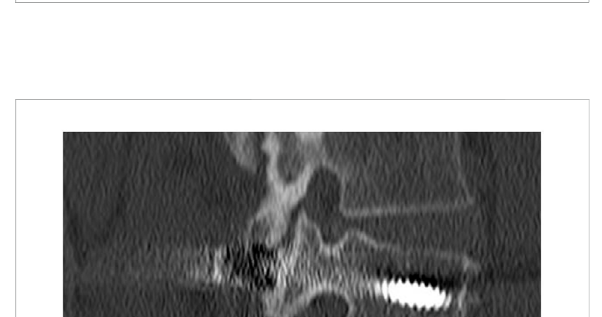
FIGURE 2 CT scan performed at 18-month follow-up, showing radiographic fusion at levels L4 – L5 and L5 – S1 where SintLife was used.